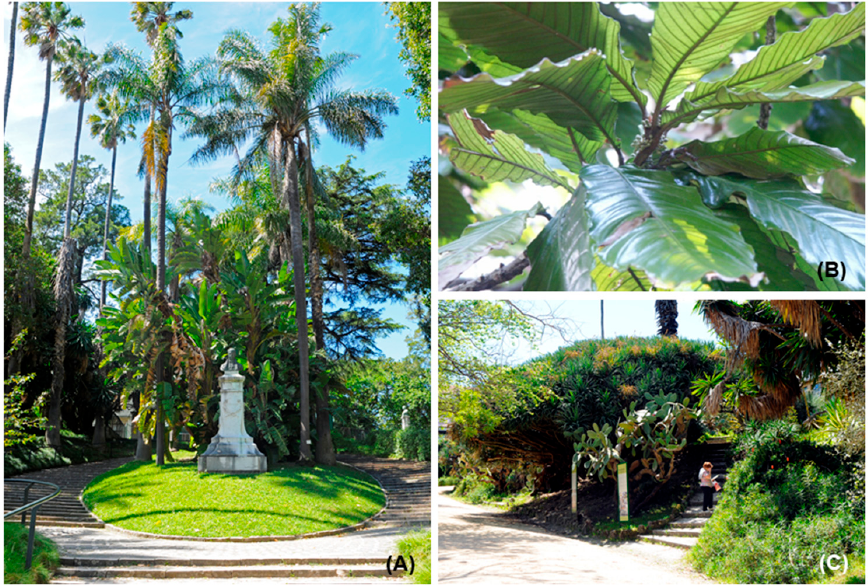
Figure 7. The iconic specimens of JBL: ( A ) Garden perspective showing the outstanding diversity of palms; ( B ) Chrysophyllum imperiale; and ( C ) Dracaena draco (Photos A and C : Sachetti; Photo B : Forte).